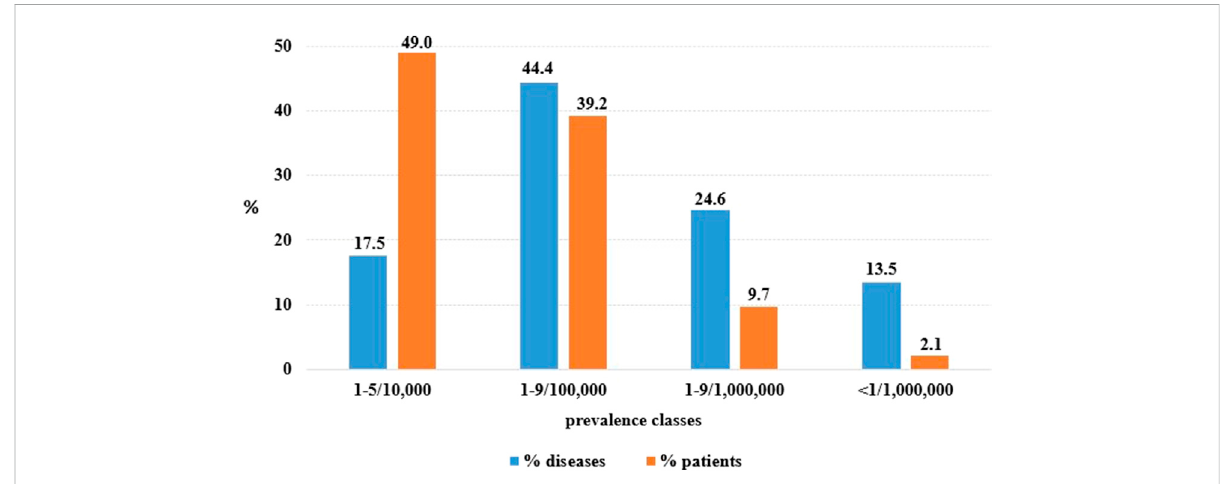
FIGURE 5 OMP use per diseases entities and rare disease patients according to disease point prevalence classes (prevalence data source: Orphanet DB).